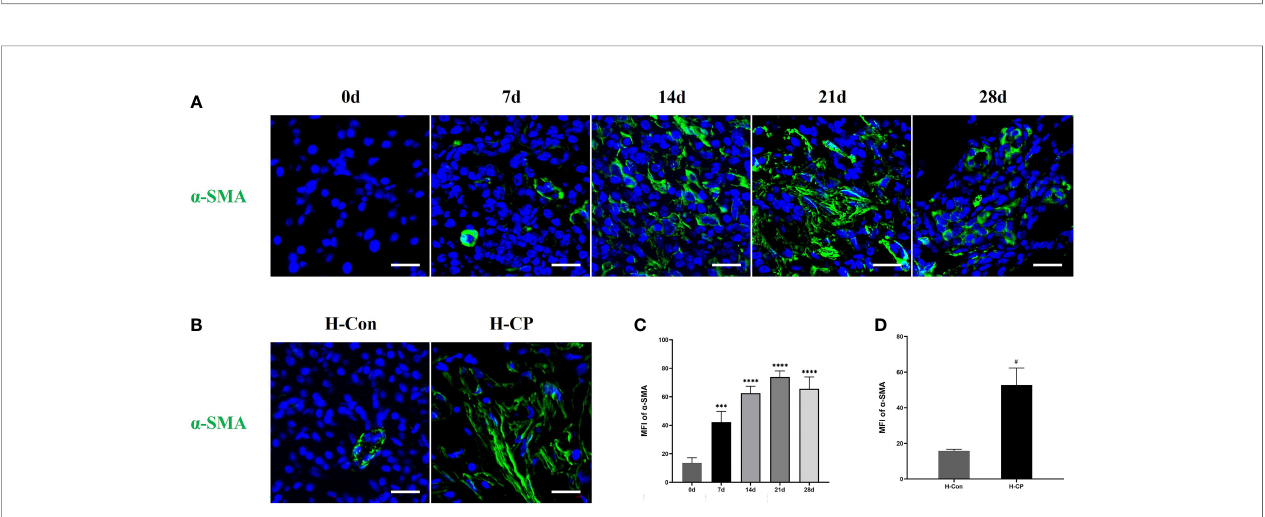
FIGURE 4 | The expression of pancreatic a -SMA was signi fi cantly upregulated in CP mouse at 14d, 21d, and 28d post ligation and peaked at 21d, it was also upregulated in human CP specimens compared to normal tissue. (A) Immuno fl uorescence staining of pancreatic a -SMA in mice at different time points. (B) . Immuno fl uorescence staining of pancreatic a -SMA in human specimens. (C) MFI of pancreatic a -SMA at different time points in mice. (D) MFI of pancreatic a -SMA in human specimens. Values are shown as means ± SE. n = 3 per group. ***P < 0.001, ****P < 0.0001 versus 0d. # P < 0.05 versus H-Con. Scale bar=20 m m. H-CP, human chronic pancreatitis; H-Con, human control; MFI, mean fl uorescence intensity.